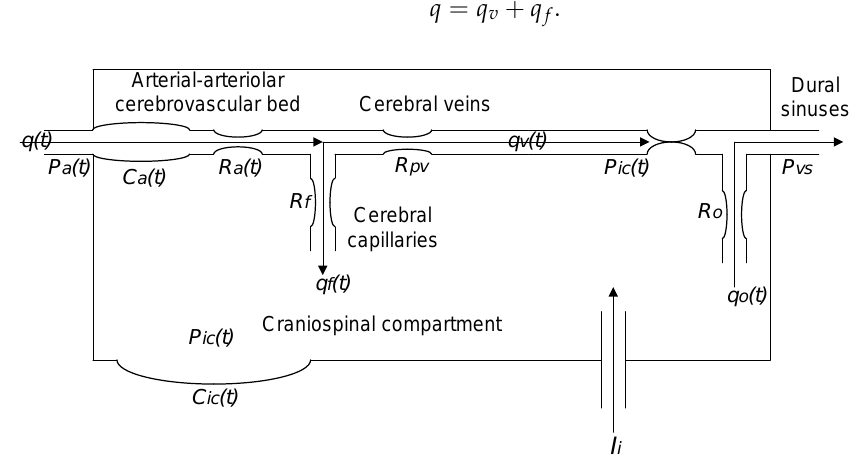
Figure 1. The cerebral hemodynamics model components and